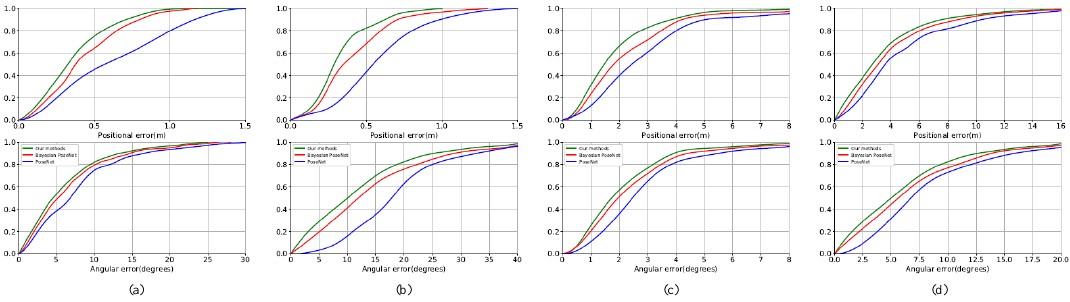
Figure 12. Localization performance from left to right: ( a ) pumpkin, ( b ) stairs, ( c ) King’s College, ( d ) St Mary’s Church. These figures show our localization accuracy for both position and orientation as a cumulative histogram of errors for the entire testing